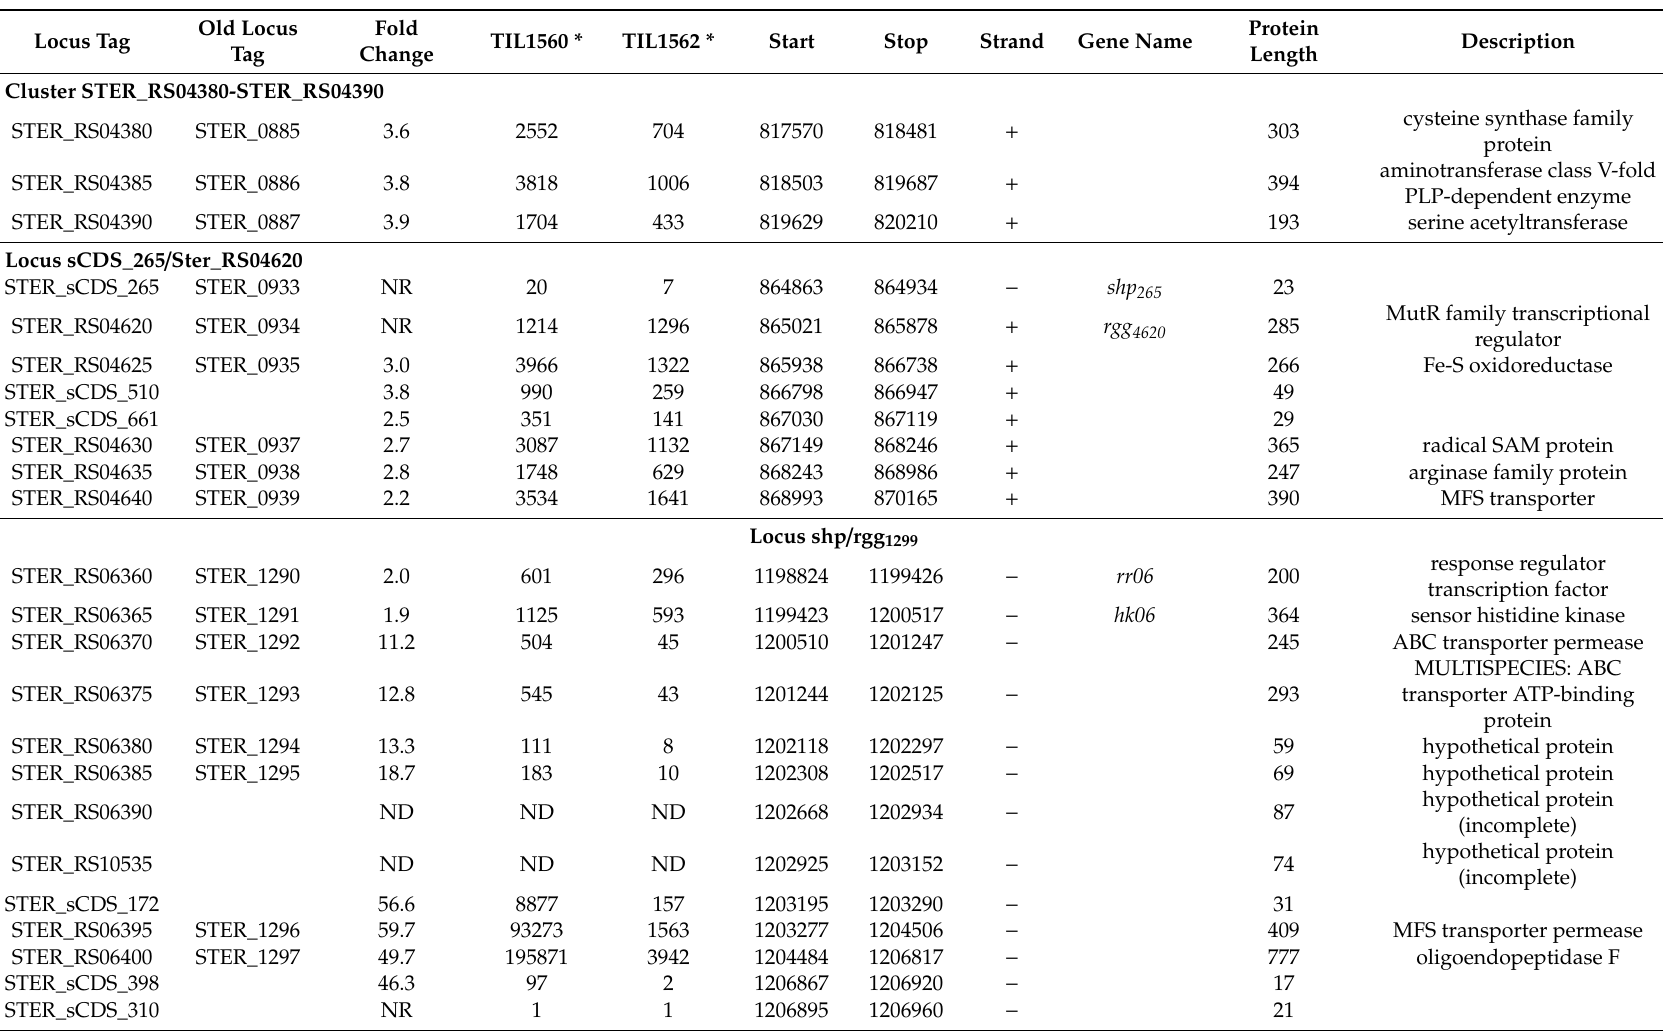
Table 2. Genes significantly upregulated in the TIL1560 strain (comR::aphA3) versus in the TIL1562 strain (comR::aphA3 ∆ pptAB) (positively controlled by PptAB). Locus